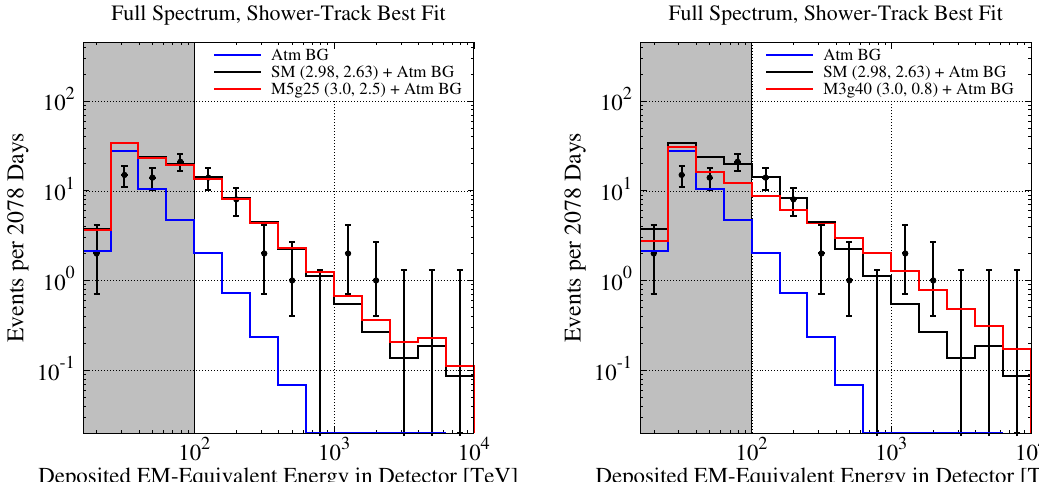
Figure 13 . Comparison between the SM and LQ best (cid:12)t curves to the IceCube 6-year dataset. In the left panel we show the best (cid:12)t curve for ( m (cid:1) ; g c(cid:28) ) = (500 GeV ; 2 : 5), which is one representative L j j case of scenarios with 2 ln L = 16 : 7. In the right panel, we show the best (cid:12)t curve for ( m (cid:1) ; (cid:0) (300 GeV ; 4), which has a p-value around 0.05 and therefore it is in tension with current data. In the plot legend we quote within parentheses the best (cid:12)t values of (cid:13) and C 0 for each model. into b(cid:28) [70, 71], c(cid:23) [74] and t(cid:28) [72, 73], cf. discussion in section 2. We see that the parameter region accessible to IceCube increases at a modest pace with the luminosity corners ( m = 300, g c(cid:28) = 1) and ( m = 600, g c(cid:28) = 4) only with about 20 and 40 (cid:1) (cid:1) L j L j j j